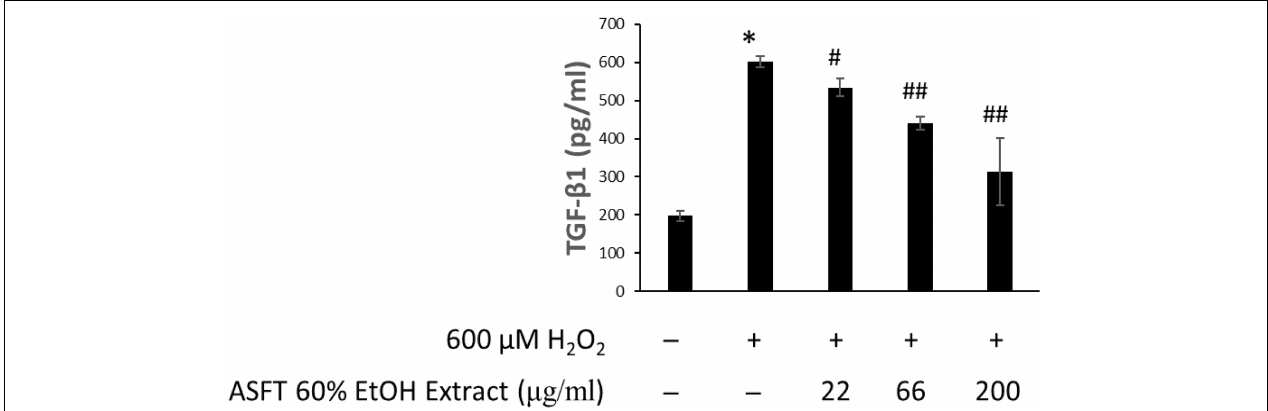
FIGURE 8 | Inhibitory effect of 60% ethanol extract from ASFT on TGF- β formation. The cells were pre-incubated with the indicated dose of 60% ethanol extract from ASFT and treated with H 2 O 2 . TGF- β formation was measured as described in “Materials and Methods.” Data were expressed as mean ± SD. * P < 0.001 vs normal group. # P < 0.05 and ## P < 0.01 vs H 2 O 2 -treated group. +, present; –,